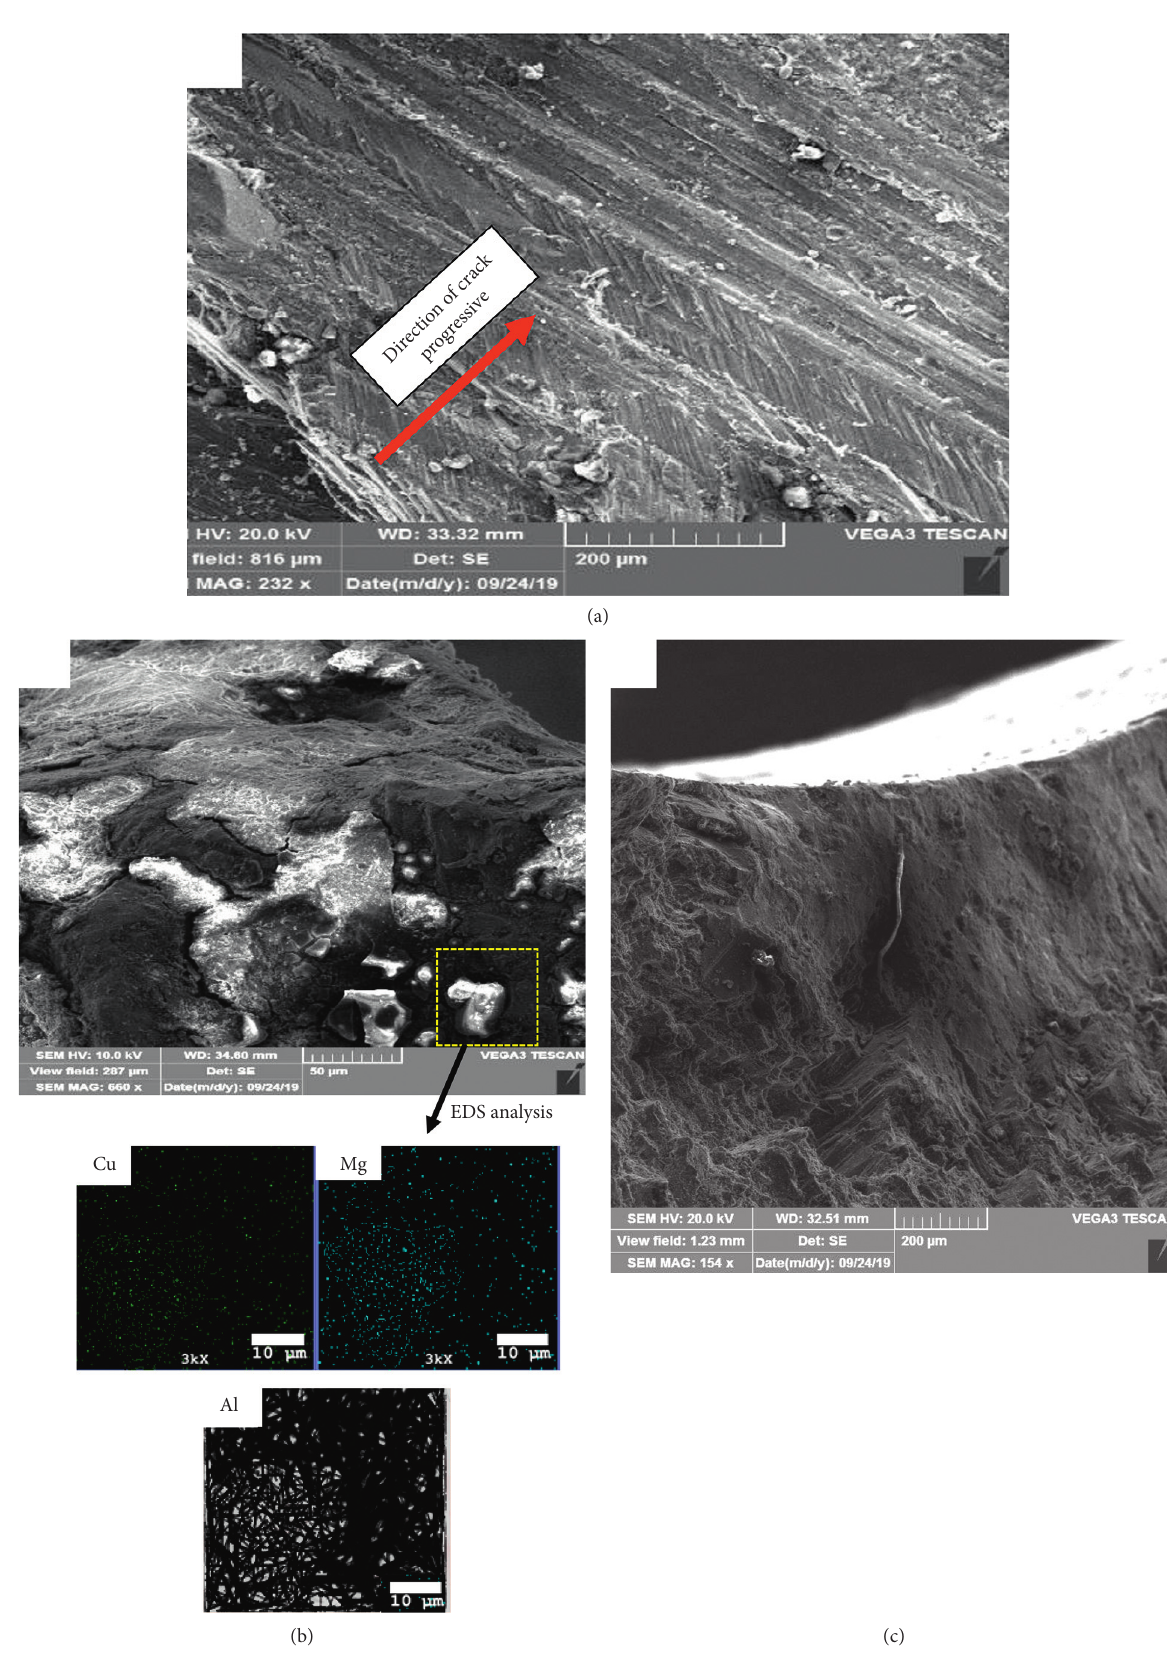
Figure 6: SEM image of fractured surface of sample 3 (according Figure 4) (a) zone A (b) zone B and (c) zone